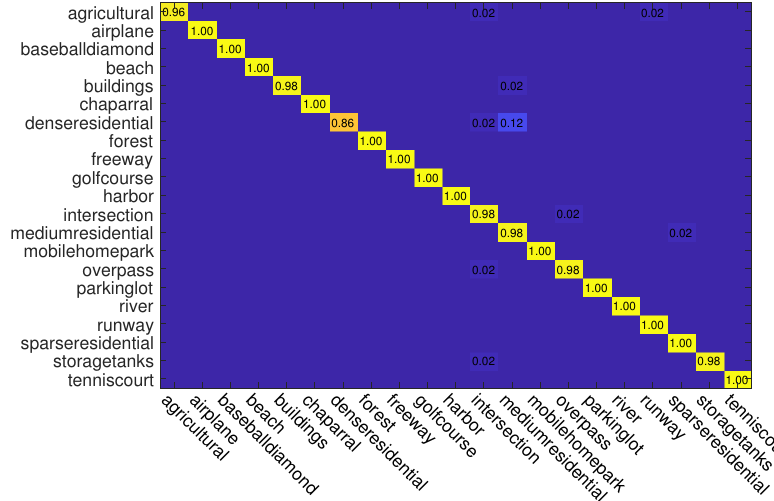
Figure 6. Confusion matrices obtained by ADRL-Net with ResNet50 as backbone on UC Merced dataset. Tr = 50%.